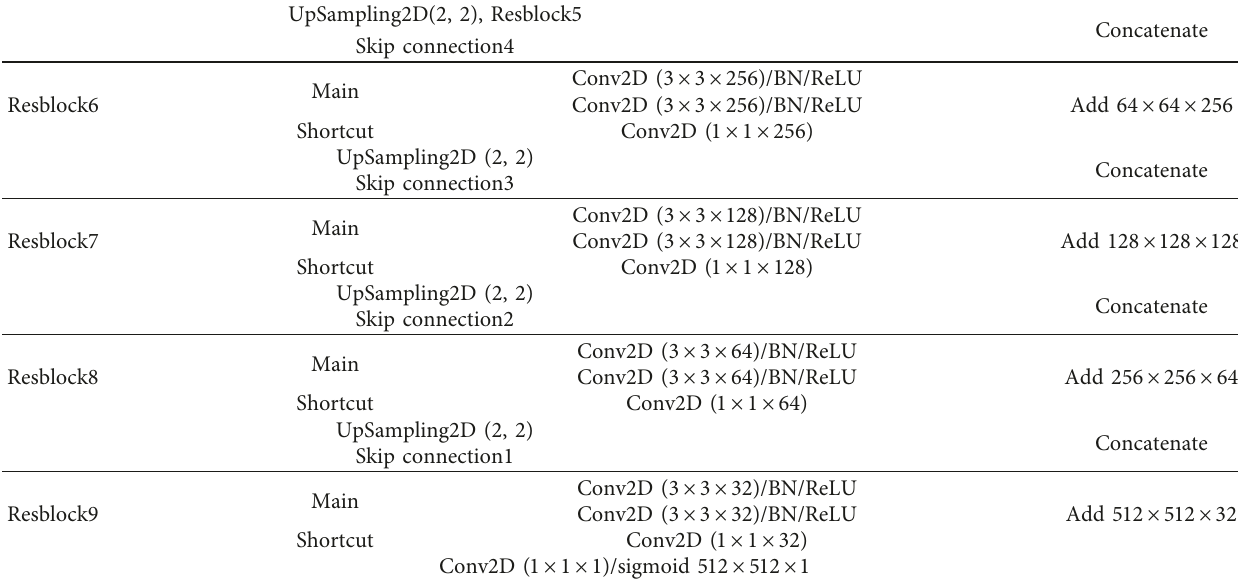
Table 2: The structure of the decoding module in our segmentation